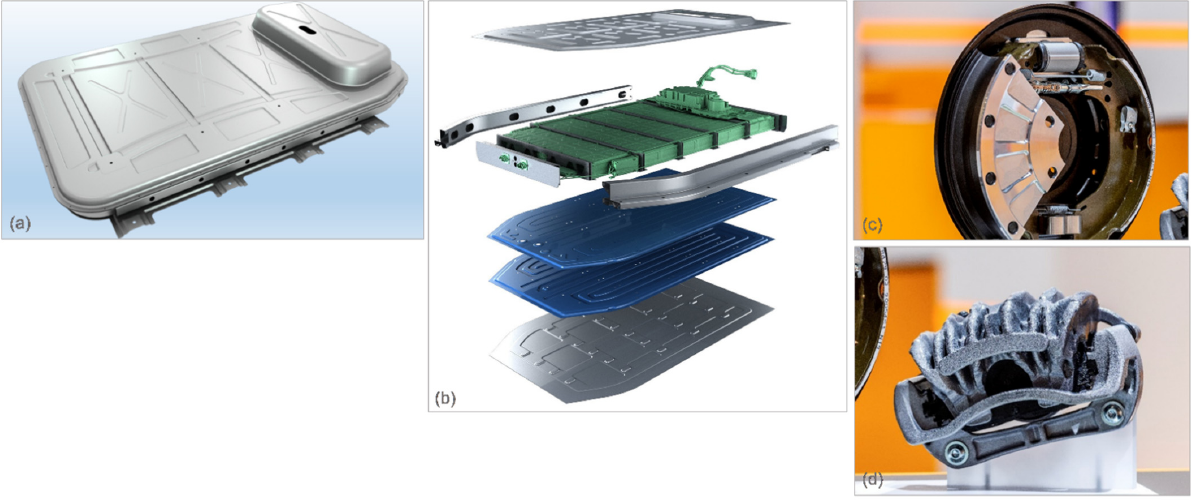
Figure 12. Considered application of aluminum in electric cars: ( a , b ) aluminum sheet battery enclosures of 1st and 2nd generation by Novelis [54] and ( c , d ) concept of lightweight drum brake and bionic-inspired caliper by Continental [55].